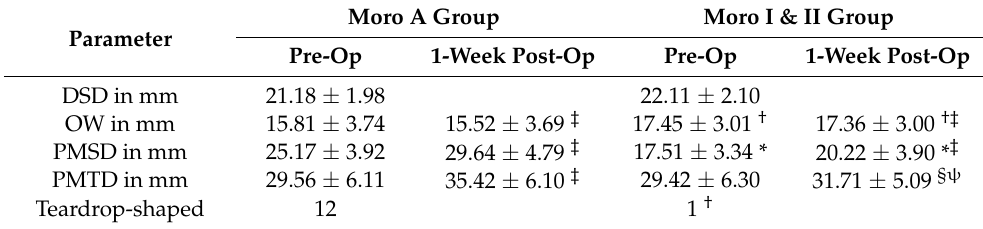
Table 3. Imaging parameters.